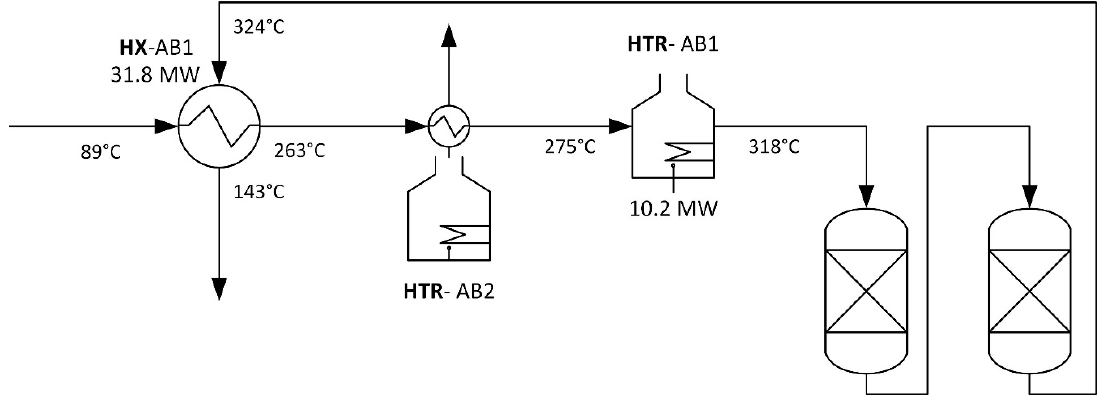
Figure A5. Retrofit proposal 2.